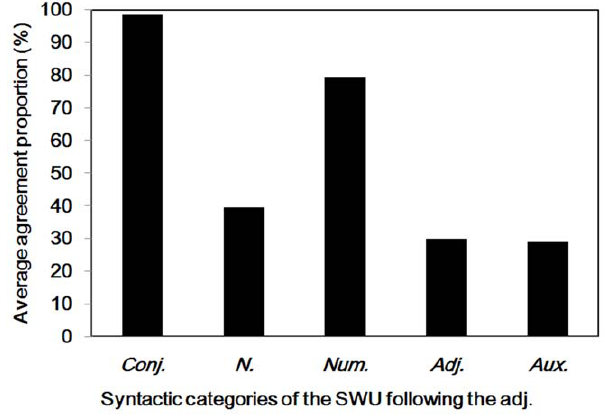
Figure 8. Adjectives. Frequency distribution of agreement propor- tions for word boundaries before (open squares) and after (filled circles) the adjectives. The y-axis represents the proportion of SWU. The number of SWU is also represented in the figure.